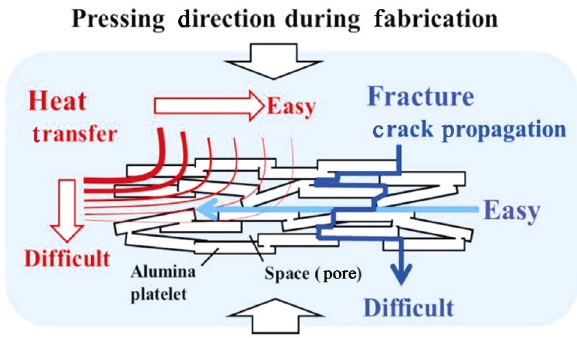
Fig. 1 Schematic diagram of the microstructure and anisotropic mechanical properties and thermal conductivities of a lamellar textured porous α-Al 2 O 3 specimen prepared by HP. Reproduced with permission from Ref. [40], © Elsevier Ltd and Techna Group S.r.l.